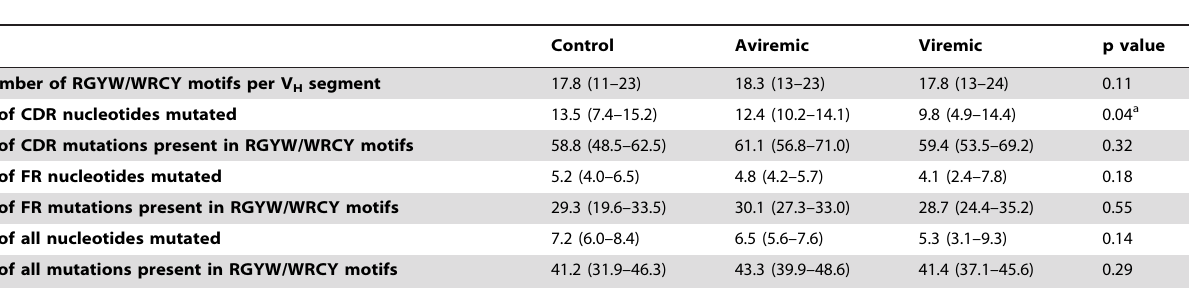
Table 3. RGYW/WRCY motifs and targeted mutation frequencies in CDR and FR